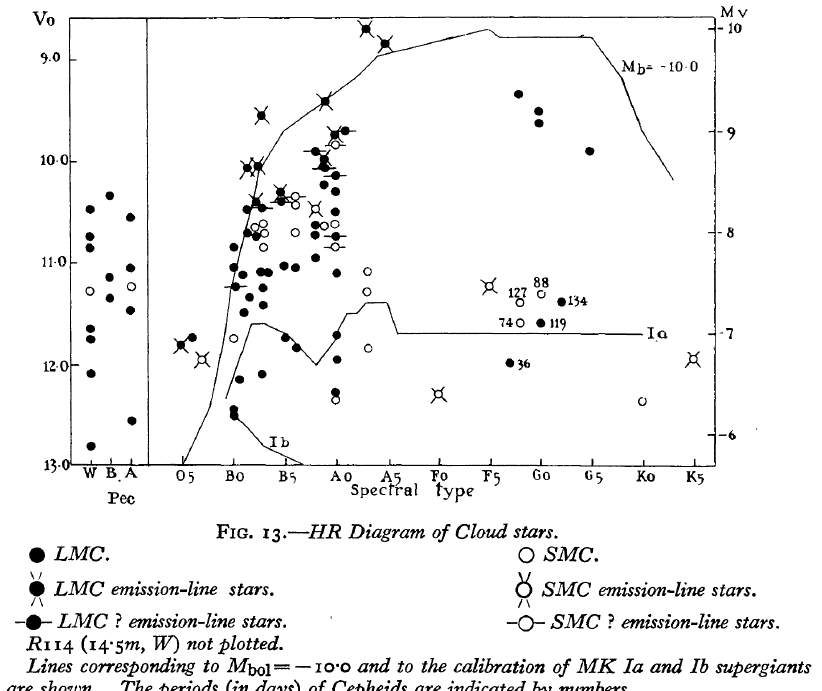
Figure 1. The HR Diagram for the brightest stars in the LMC and SMC from [5]. LMC stars are closed symbols and those in the SMC are shown as open